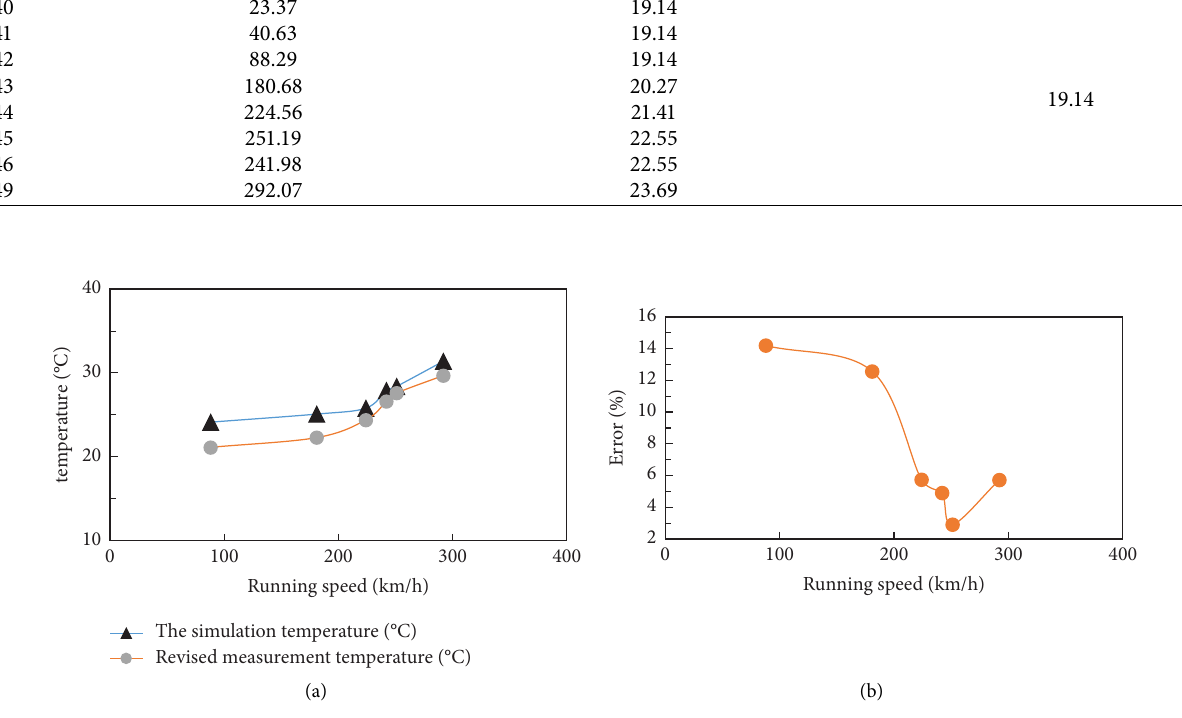
Figure 8: Comparison between the simulation results and experiment results: (a) trend of simulation temperature and measurement temperature and (b) error of simulation temperature and measurement